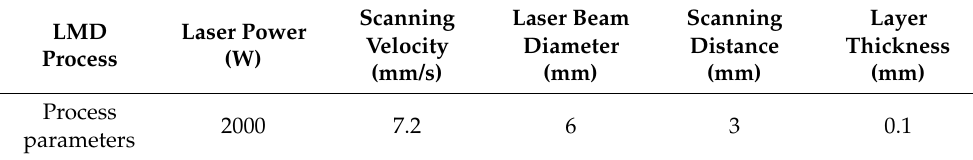
Table 3. Process parameters for laser-melting deposition.